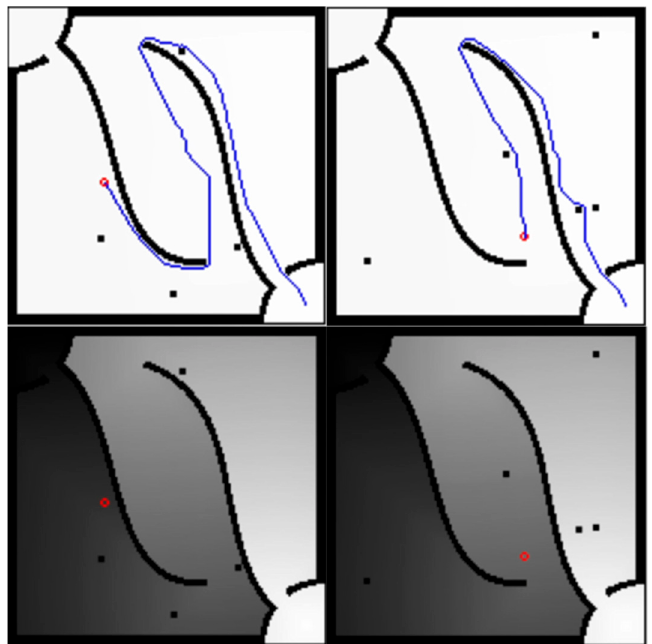
Figure 3. Real-time path planning without the distance cost to obstacles and walls.